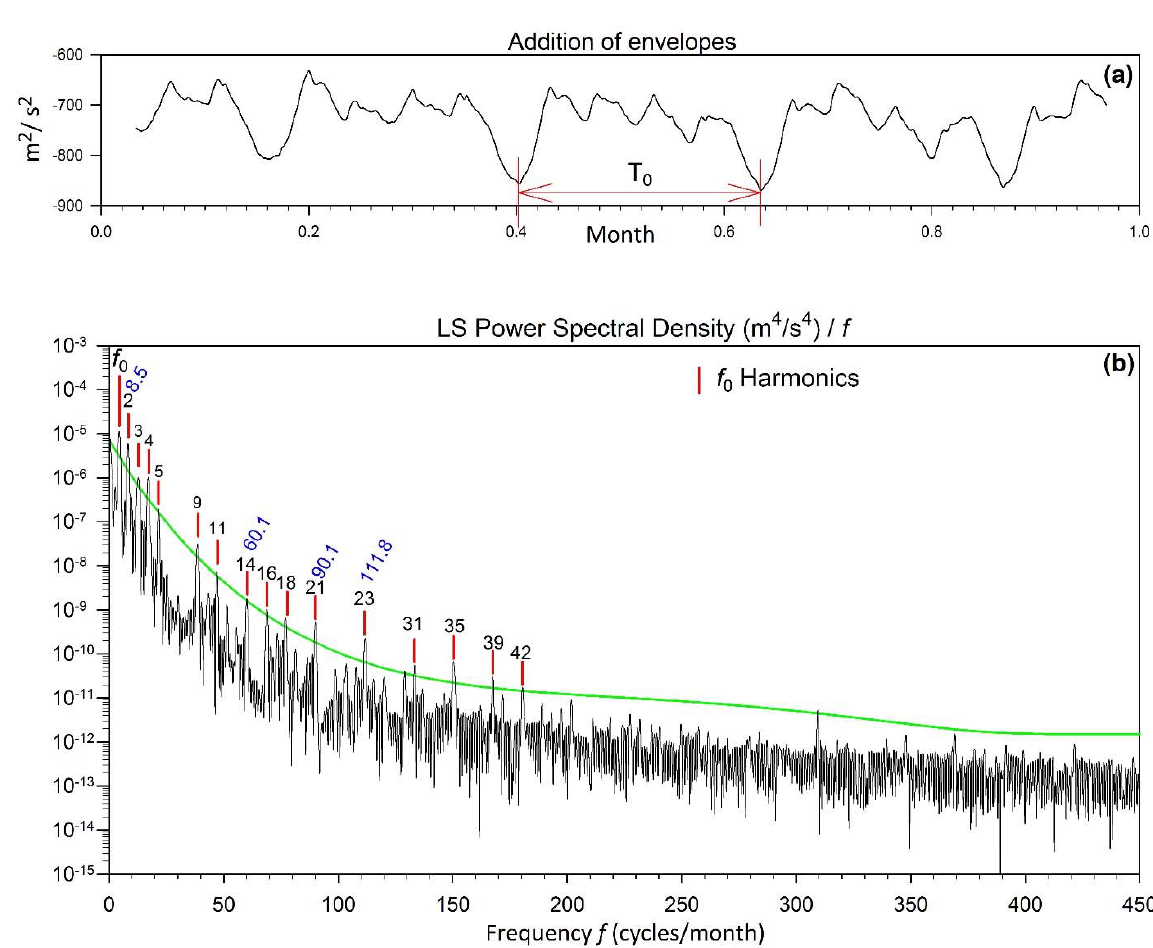
Figure 7. Panel ( a ) shows the superposition of the 15 modulating envelopes for the entire month of June 2009 with a clear fundamental frequency f 0 = 1/ T 0 of about 4 CPM. Panel ( b ) depicts the least-squares power spectral density of the sum of the modulating envelopes. The vertical red lines mark the harmonics of the fundamental frequency, with the number (black font) showing the harmonic. Numbers in blue font signify a few frequencies in CPM discussed in the text. The green line shows the 95% prediction level.